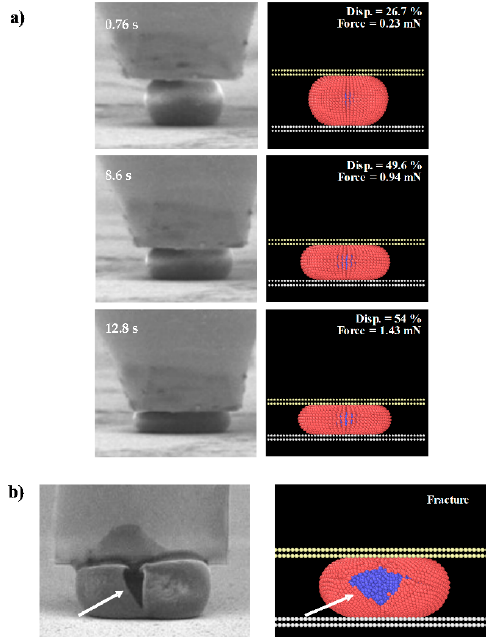
Figure 5. ( a ) Comparison between the deformation under coaxial load and ( b ) the fracture of a simulated elastic single liquid core–shell capsule by the Discrete Multi-Physics (DMP) approach and an elastic capsule of 16–50 µ m being ruptured (from